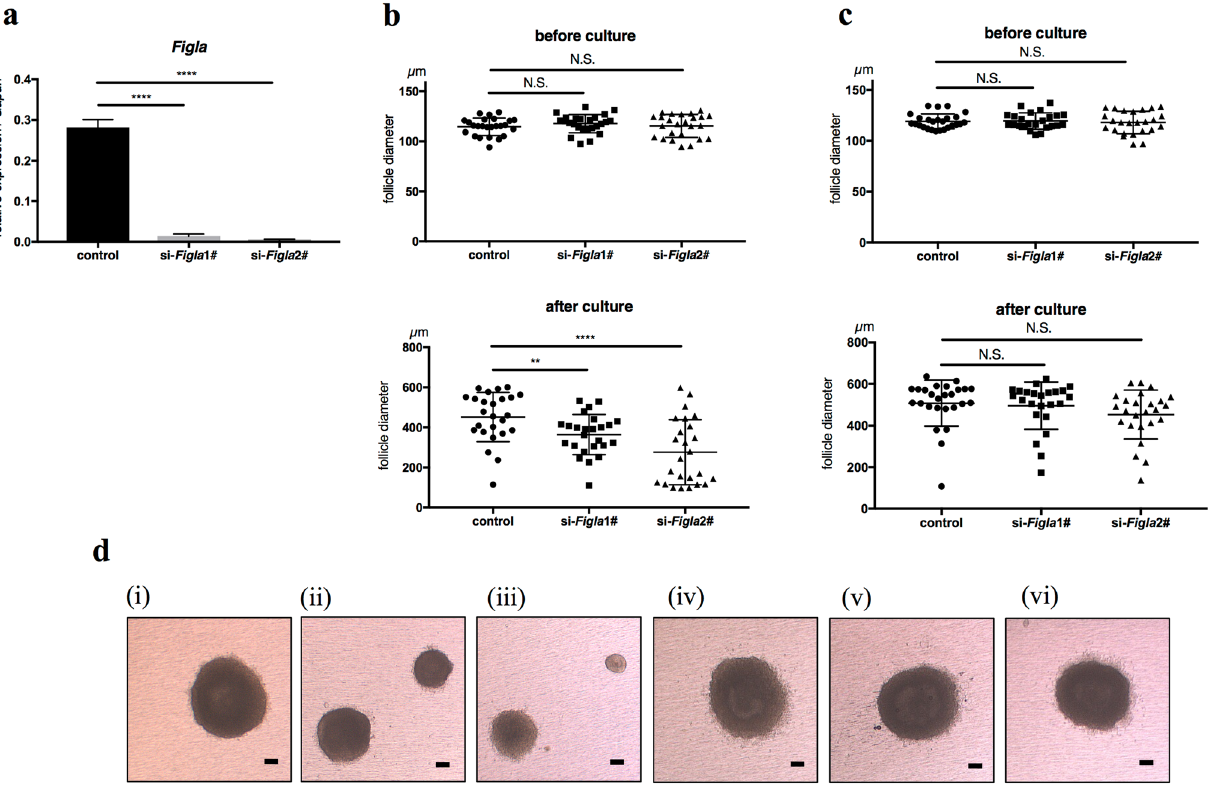
Figure 3. Reduced follicle growth of si- Figla in mature mice. ( a ) The expression of Figla was significantly weaker in si- Figla (1# left, 2# right) secondary follicle oocytes than in the control (n = 3, for each group). ( b , c ) The diameters of follicles before culture (upper graph) and after 12 days of in vitro culture (lower graph) are shown. The diameter of si- Figla was significantly smaller than the control after culture in mature mice ( b ), whereas no significant difference was observed in premature mice ( c ). The diameters of mature mouse follicles before culture were 114.6 ± 8.69 µm (n = 25) in control, 117.8 ± 8.98 µm (n = 25) in si Figla 1#, and 115.4 ± 11.35 µm (n = 25) in si- Figla 2#, whereas diameters after culture were 452.1 ± 123.2 µm (n = 25) in control, 364.7 ± 100.4 µm (n = 25) in si- Figla 1#, and 276.2 ± 162.8 (n = 25) µm in si- Figla 2#. The diameters of premature mice follicles before culture were 119.0 ± 7.31 µm (n = 26) in control, 119.4 ± 8.07 µm (n = 24) in si- Figla 1#, and 117.9 ± 11.0 µm (n = 25) in si- Figla 2#, whereas diameters after culture were 508.0 ± 110.5 µm (n = 26) in control, 495.8 ± 113.2 µm (n = 24) in si- Figla 1#, and 453.2 ± 117.4 µm (n = 25) in si- Figla 2#. ( d ) Representative pictures of follicles after 12 days of in vitro culture, (i)–(iii) mature mice, (iv)–(vi) premature mice, (i), (iv) control, (ii), (v) si- Figla 1#, (iii), (vi) si- Figla 2#. Scale bars, 100 the formation of secondary follicles 29 , and it currently remains unclear whether it has any effects on secondary follicles. Additionally, since an estrogen stimulation during primordial follicle formation in the neonatal ovary was shown to impair follicle formation 30, 31 , an excessive estrogen stimulation in the secondary follicle may also impair follicle growth. These findings indicate that Figla promotes follicle formation by suppressing estrogen signaling in oocytes during early oogenesis, and also that the suppression of estrogen signaling in the secondary follicle may contribute to the appropriate regulation of follicle growth. VDR/RXR activation was up-regulated by Figla in secondary follicles, but not in neonatal ovaries. VDR is a nuclear receptor for vitamin D that promotes the transcription of its downstream target genes by forming heterodimers with RXR, the positive immunostain- ing of which has been reported in the secondary follicle oocytes of primates 32 . Studies on VDR knockout mice reported that primordial follicle formation during the neonatal state was not impaired, whereas follicles in devel- opmental stages later than secondary follicles disappeared in the ovaries of 7-week-old mice 33 , suggesting that Figla advanced secondary follicles to later stages of development by VDR/RXR activation, a function that may be characteristic of secondary follicles. However, it currently remains unclear how this function is characteristic of secondary follicles. Figla is one of the basic helix-loop-helix (bHLH) transcription factors 17 . The binding motif of Figla , called E-box (CANNTG), is common to bHLH transcription factors 34 , and Figla functions with a cofactor called E12 when it regulates its downstream egg coat-coding genes, Zp1,2,3 16 . Similarly, VDR/RXR activation by Figla may be due to some cofactors or epigenetic modifications 35 that are characteristic of secondary follicles. Meiotic cell cycle was up-regulated by Figla in neonatal ovaries but not in secondary follicles. This correlates to early oogenesis that germ cells enter meiosis and arrest at the diplotine stage of the first meiotic prophase when primordial follicles are created until the resumption of meiosis is induced in fully grown oocytes 36 .